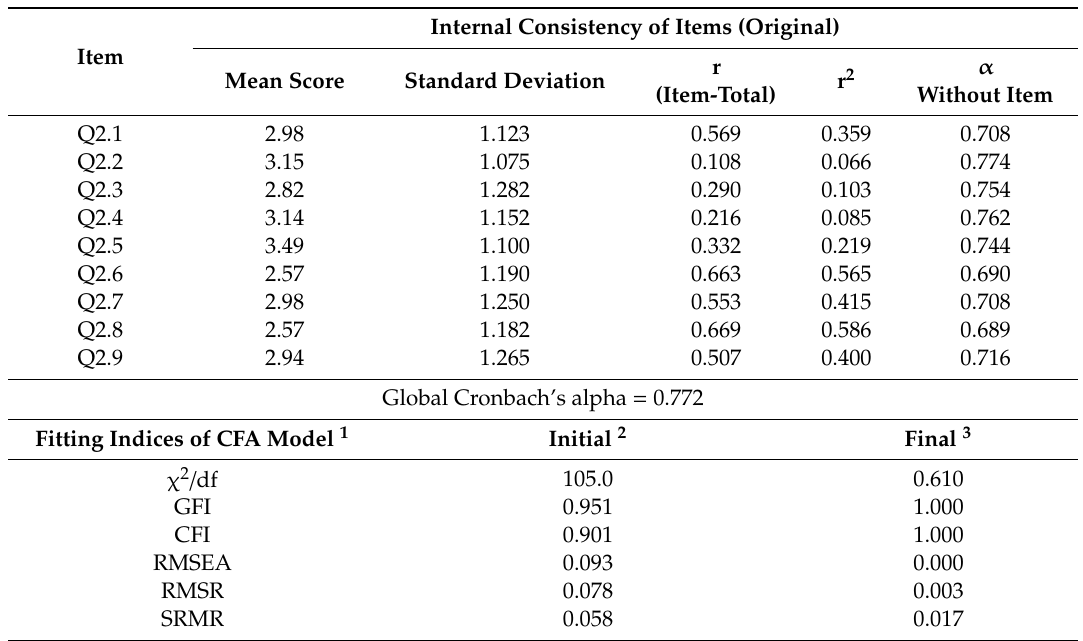
Table 2. Statistics for the unidimensional model of the scale about emotional motivations. Internal Consistency of Items (Original) Item